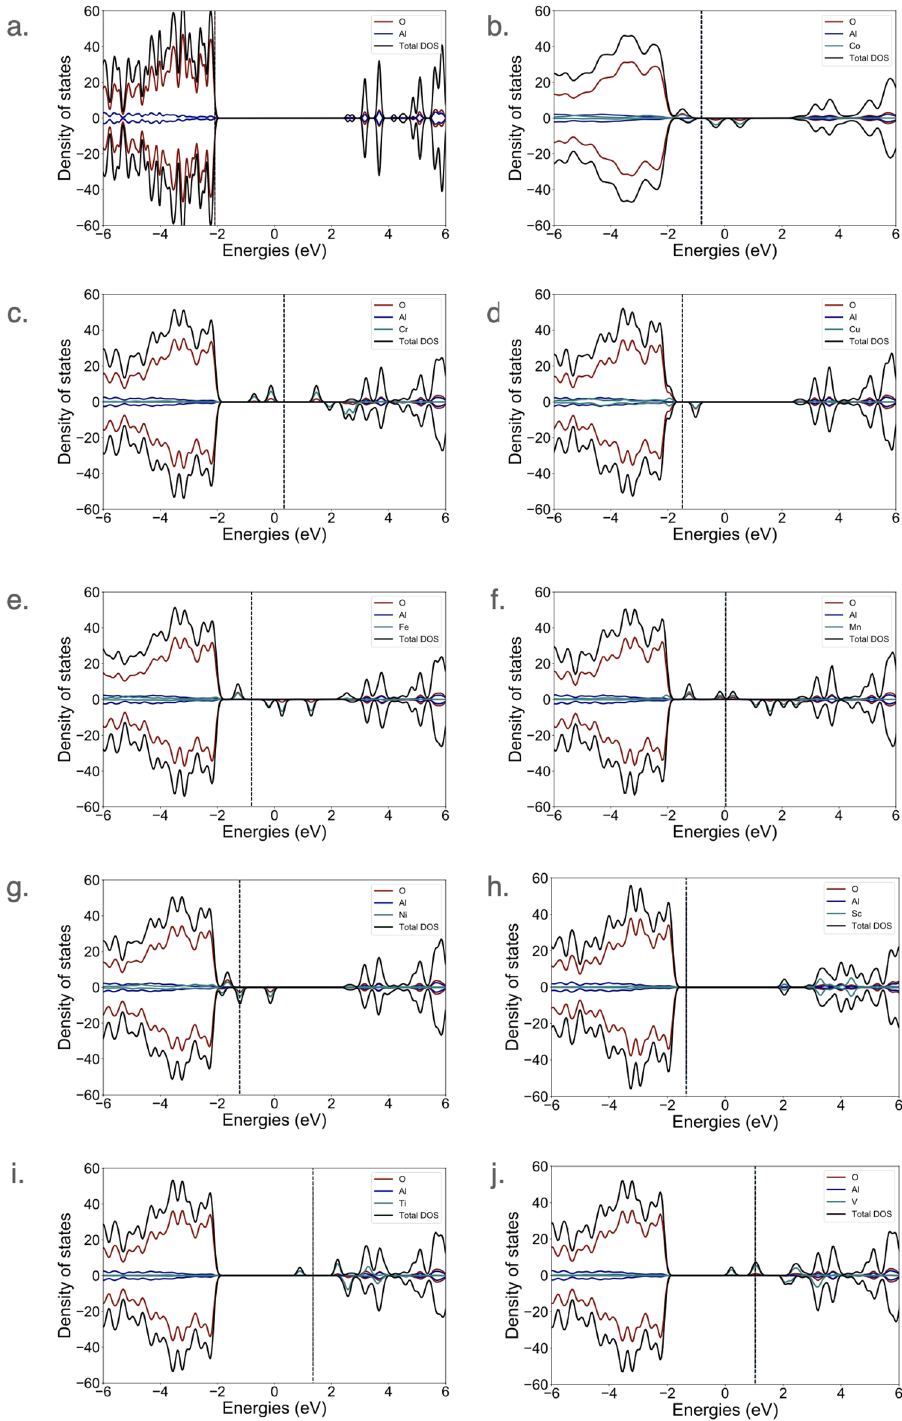
Figure 4. Element resolved density of states of pure and surface doped α -alumina illustrating the introduction of defect states in the band gap and spin asymmetries for the doped configurations. The pristine case ( a ) is compared to Co ( b ), Cr ( c ), Cu ( d ), and Fe ( e ), Mn ( f ), Ni ( g ), Sc ( h ), Ti ( i ), and V ( j ) dopants in the surface dopant configuration illustrated as position 1 in Fig. 1. The fermi level is indicated by a vertical dashed